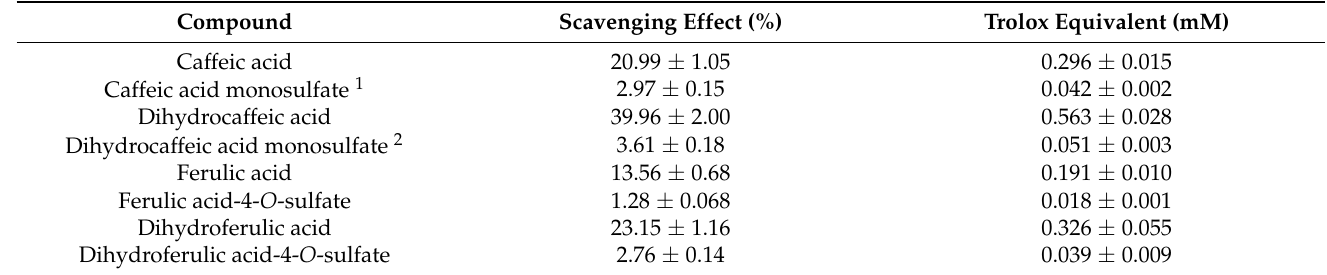
Table 3. Scavenging effects of phenolic acid and its metabolites measured with the DPPH free radical